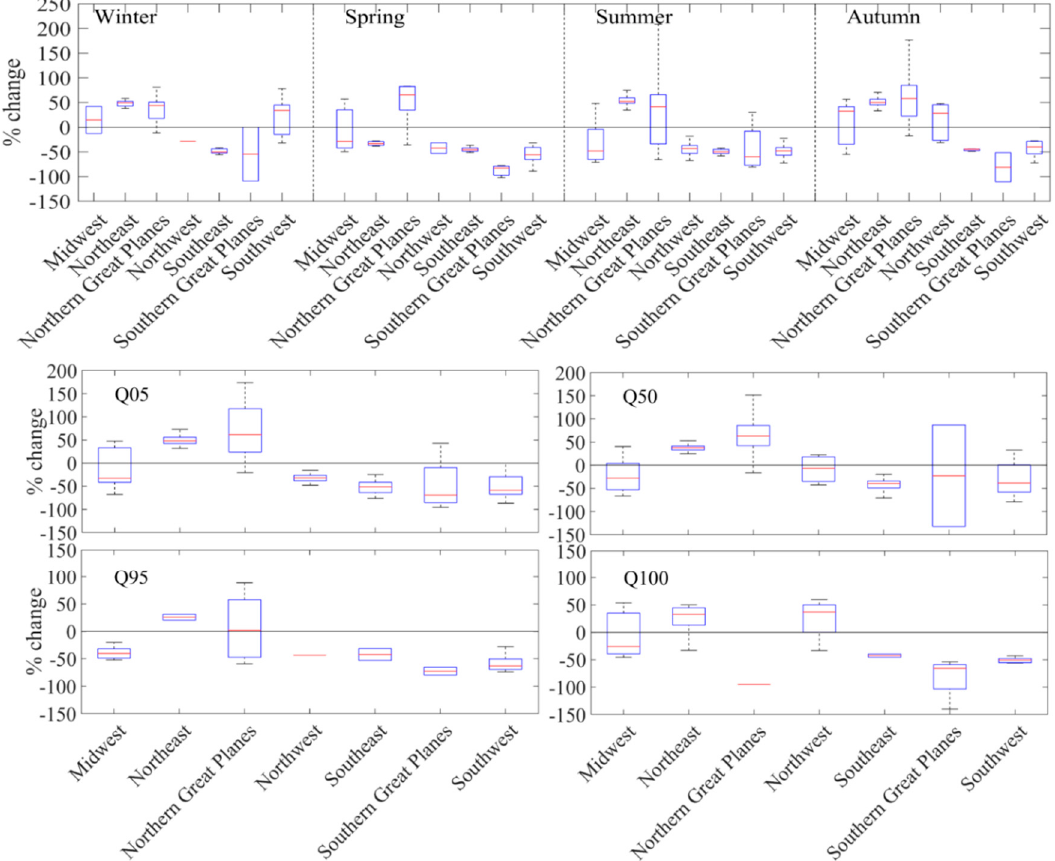
Figure 3. Box plots for the percent change in streamflow based on the Thiel–Sen slope. The percent change is calculated based on the average value of the streamflow metric during the study period. The boxes represent the distribution of the trend between 25th and 75th percentiles and the medians are represented by horizontal red lines. The outliers at 5th and 95th percentiles are shown as the whiskers.